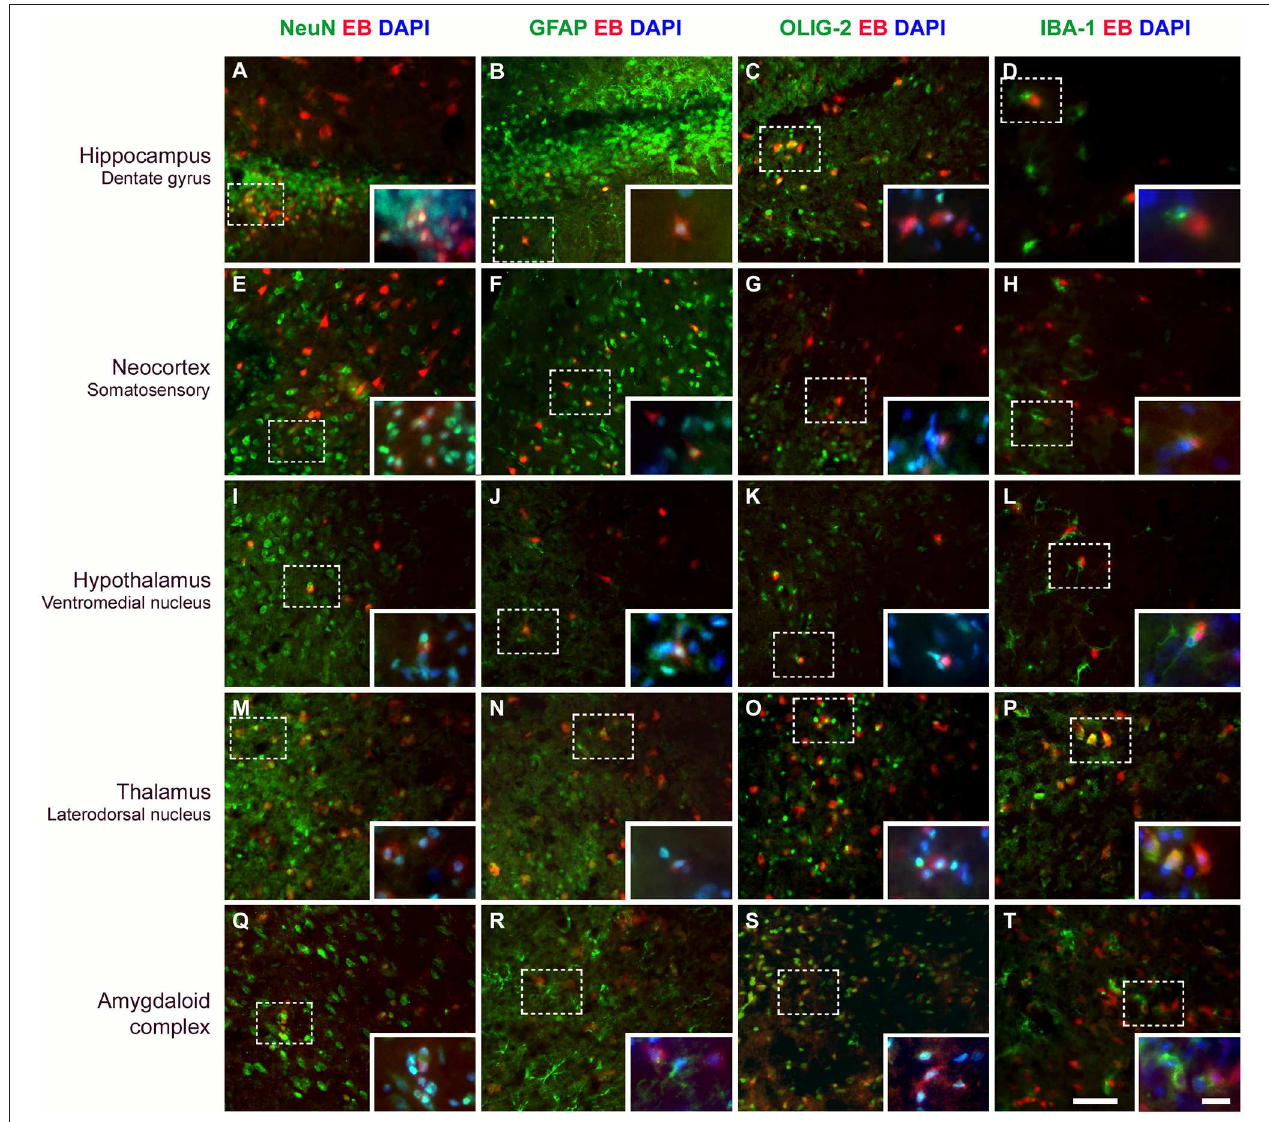
FIGURE 6 | Evans blue (EB) dye is captured by different cell types after BBB breakdown. Immunostaining for detection of neurons (NeuN), astrocytes (GFAP), oligodendrocytes (OLIG-2), and microglia (IBA-1) in various brain areas, 24h after SE. Positive cells are shown in green. After BBB breakdown, the complex albumin-EB dye enters the brain and is captured by damaged cells (shown in red). Double-staining for the cell types and the EB dye shows that they are mainly neurons, astrocytes, and oligodendrocytes (see in yellow, as a result of red and green fluorescence overlap; larger images). Inserts show higher magnification of affected cells (dotted rectangle), with nuclei evidenced with DAPI (shown in blue). White color corresponds to the green, red, and blue fluorescence overlap. The first column of images shows that neurons containing EB are observed in all analyzed areas (A,E,I,M,Q) . In the second column, astrocytes are found containing EB (B,F,J,N) or involving cells that captured the dye (see amygdaloid complex; R ). In the third column, oligodendrocytes that captured EB are also observed in all brain areas (C,G,O,S) , except in the hypothalamus (K) . The fourth column shows that microglia exhibiting thicker branches projections suggestive of activated cells are found involving the EB-containing cells (D,H,L,T) , except in the thalamus where macrophage-shaped microglia, are seen containing the dye (P) . Magnification: 400X (larger images) and 630X (inserts). Bars = 20 µ m (larger images) and 10 µ m